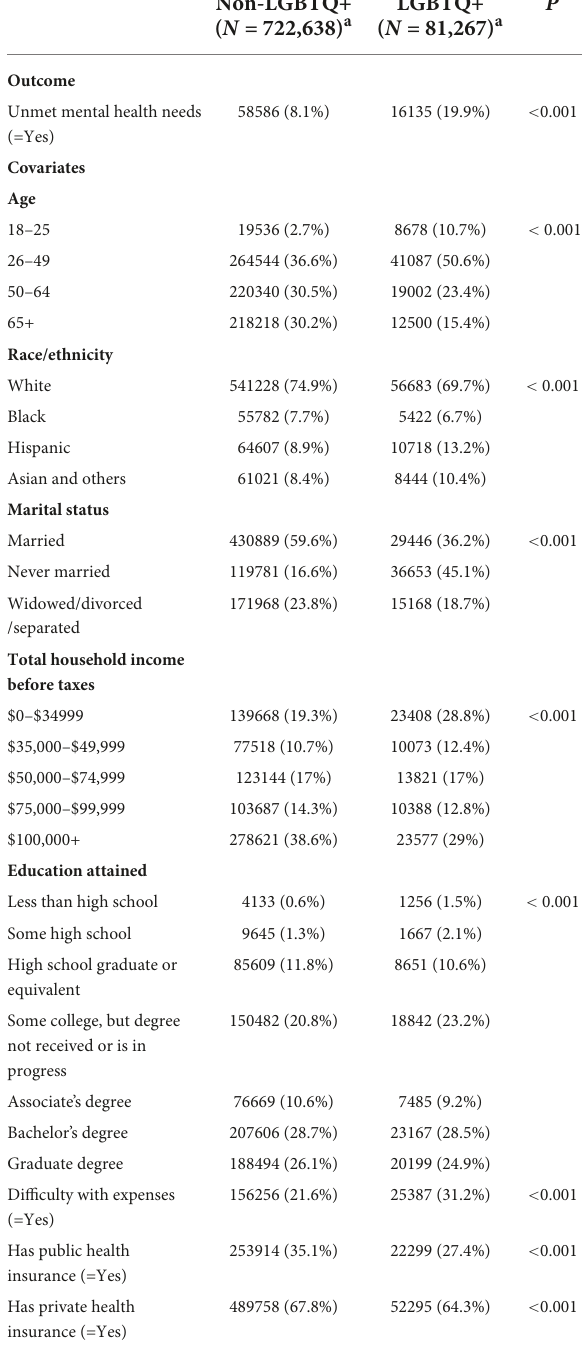
TABLE 1 Characteristics of participants in the United States from 21 July 2021 to 9 May